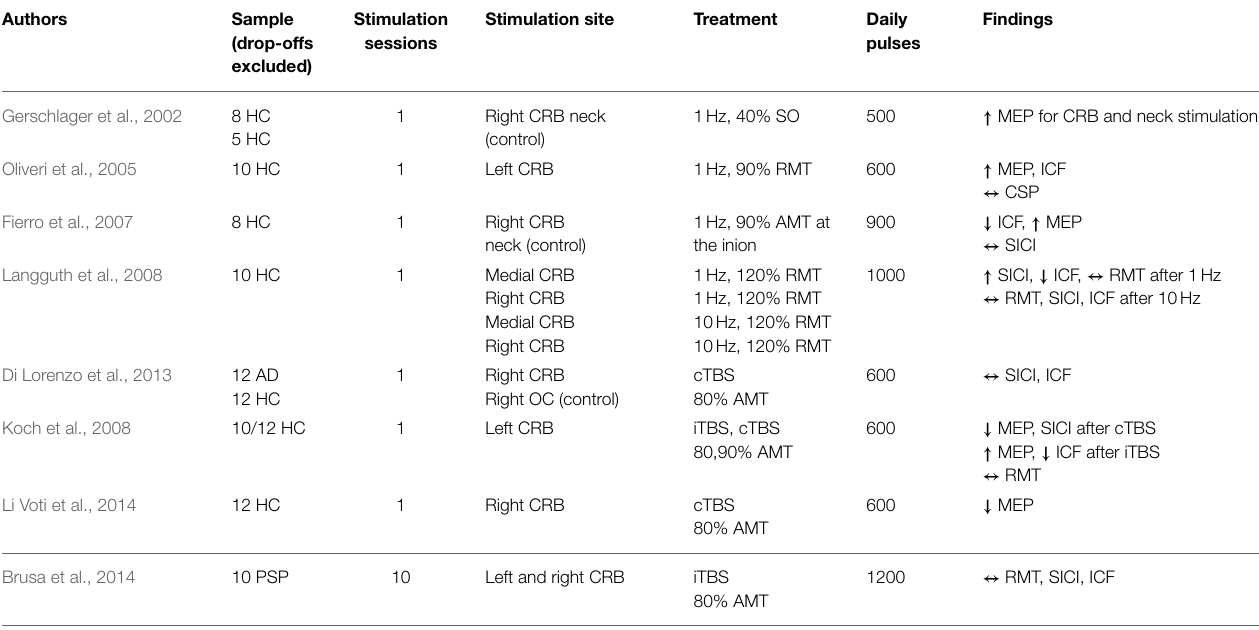
TABLE 2C | Overview of study parameters of cerebellum rTMS studies investigating motor cortex